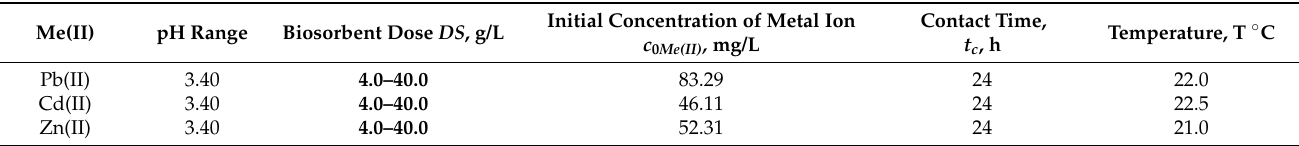
Table 3. Values of working parameters used in the experimental study of the influence of biosorbent dose on the biosorption process.